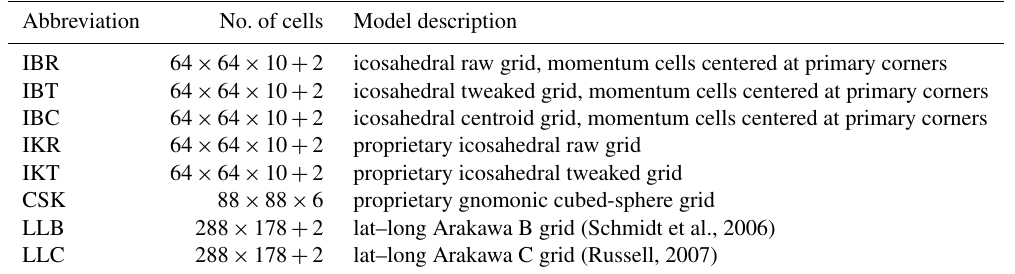
Table 2. Abbreviations, number of primary cells at 1 ◦ resolution, and model description.